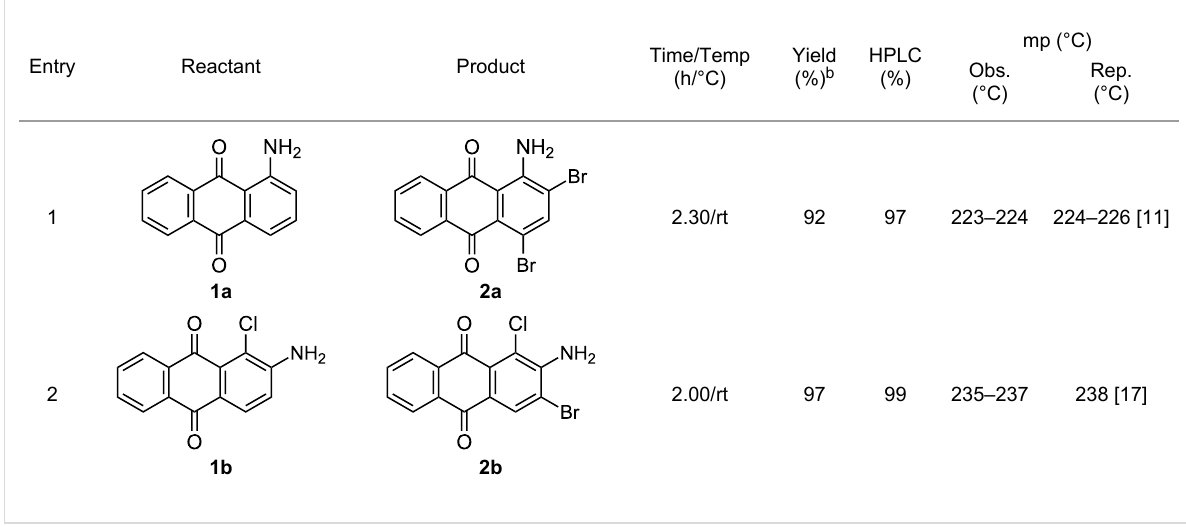
Table 4: Bromination of various aminoanthracene-9,10-dione derivatives and benzanthrone. a